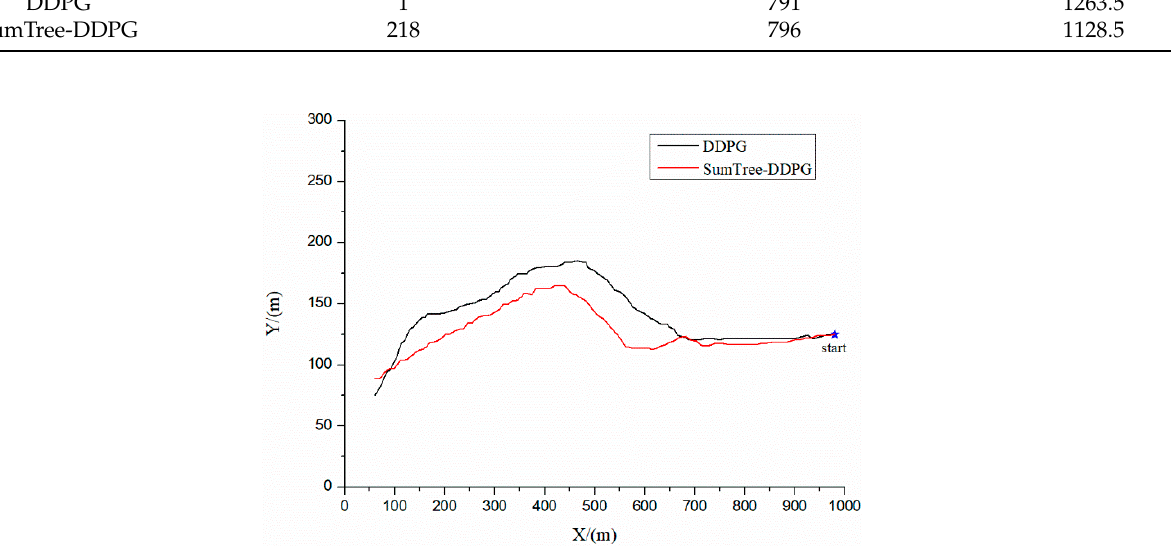
Figure 10. The optimized path of AUV in Environment 1.